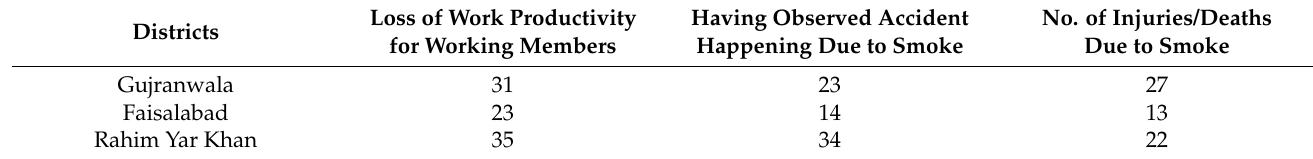
Table 4. Other issues associated with crop residue burning.